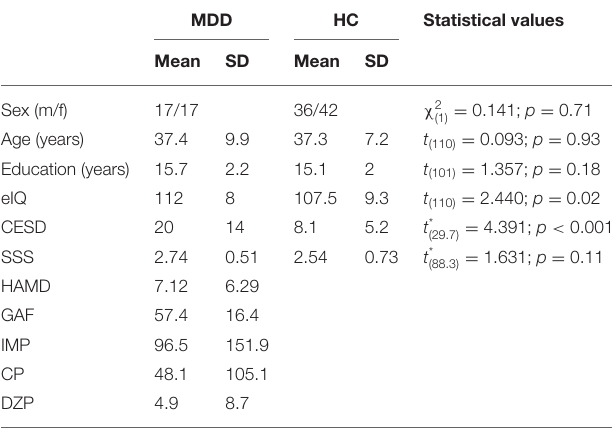
TABLE 1 | Demographic characteristics of